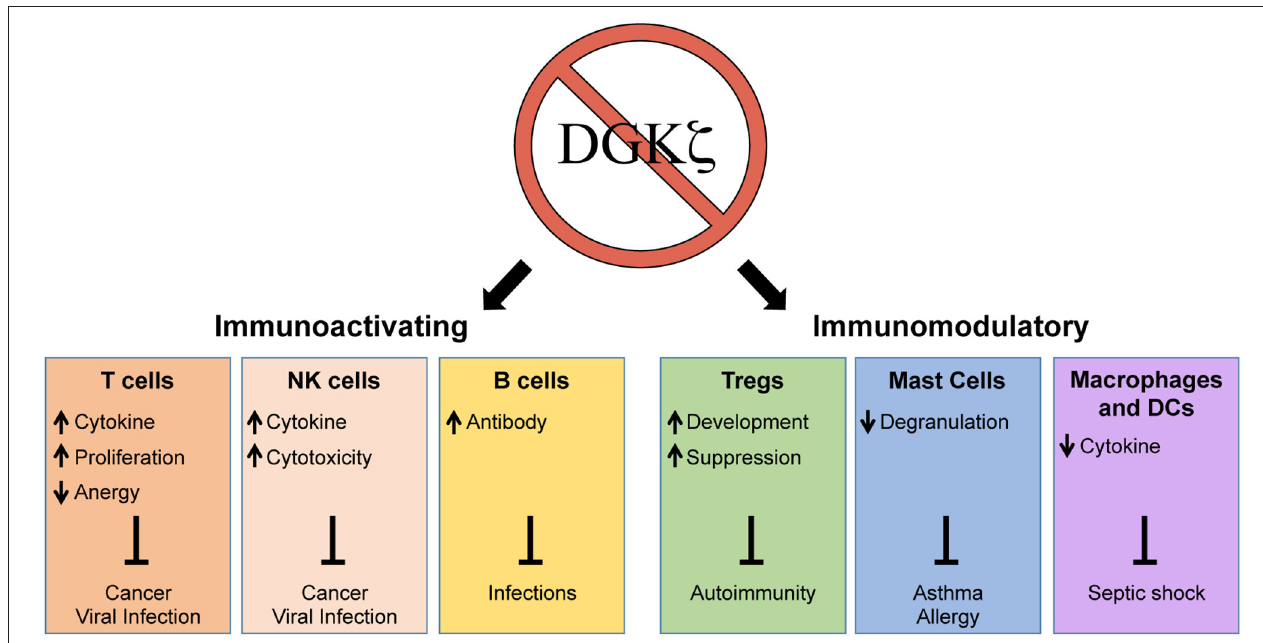
FIGURE 1 | Enhancement and suppression of selective immune functions through the inhibition of DGK ζ . The loss of DGK ζ can result in activating or modulatory effects on the immune response that can be therapeutically beneficial for the resolution or prevention of a variety of human diseases. The inhibition of DGK ζ has positive effects on T cells, NK cells, and B cells, which could promote immunity against cancer and infections. In contrast, the inhibition of DGK ζ can suppress immune responses by augmenting Treg development, inhibiting mast cell degranulation, and attenuating macrophage/DC cytokine release. These effects could be beneficial in treatment of autoimmunity, asthma/allergy, and septic shock.